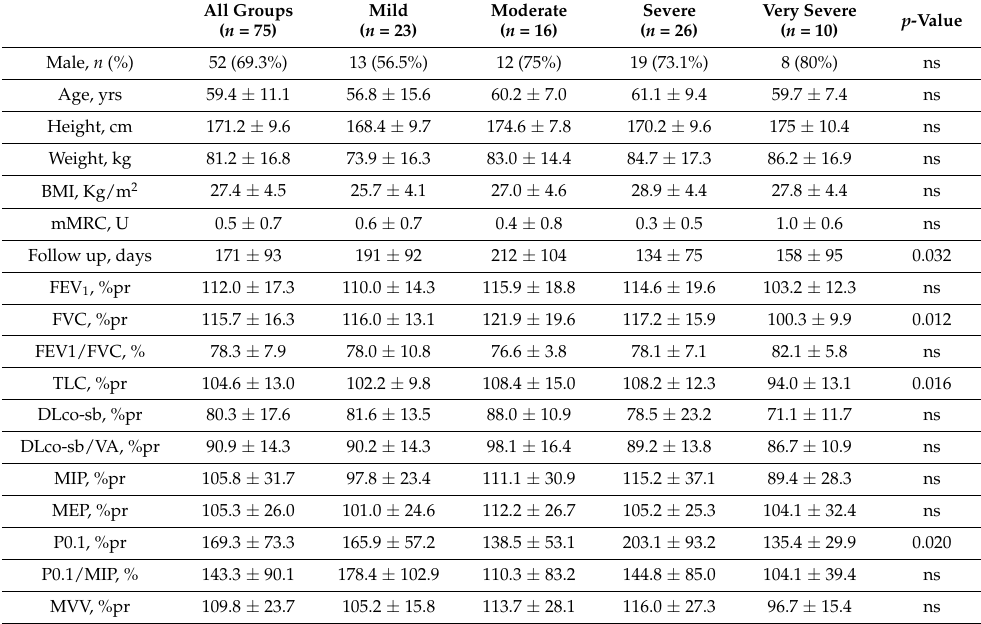
Table 1. Subjects’